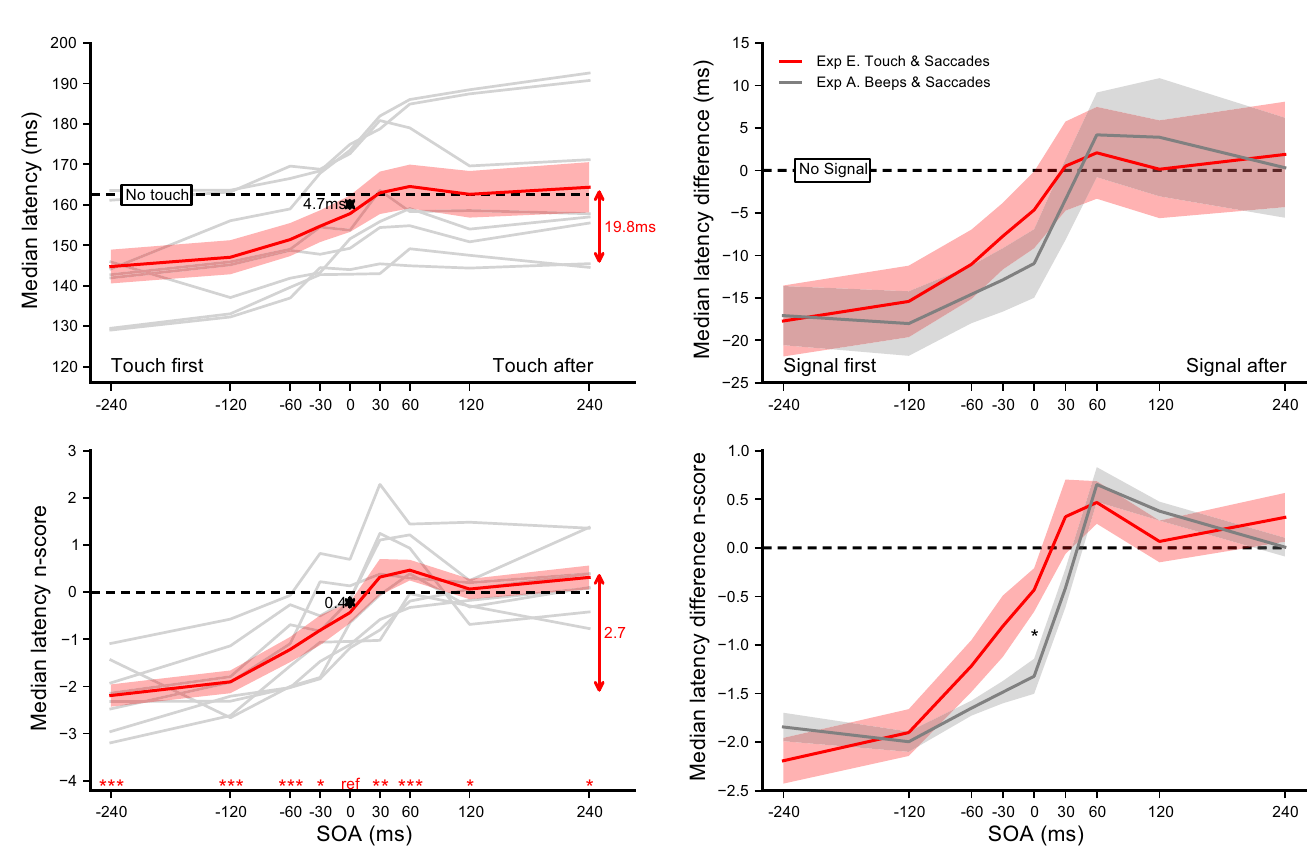
Fig 6. Experiment E. Effect of tactile stimulation on saccade onset (left panel). Median latencies averaged across participants for each SOA condition (top) and the corresponding n scores (bottom). Dashed lines show the No touch condition level and grey lines show individual results. Error bars indicate inter-individual SEM. Statistics included a single sample t-test performed on the n scores of the SOA = 0 ms reference condition to highlight the difference with the No touch condition (black arrow), and paired t-tests comparing this reference with each of the other SOA condition (red stars for each SOA above the X-axis). Auditory beeps vs. tactile vibration (right panel). Comparison between experiment E (red plot) and A (grey plot): median latency differences (top) and n score differences (bottom) aligned on the No signal condition (dashed lines). Statistics were unrelated t-tests performed on the n score differences between experiments for each of the 9 SOA conditions. Three stars indicate highly significant differences after Bonferroni correction (p < 0.00555) while single stars and two stars significant differences without correction (p < 0.05 and p < 0.01 respectively). Red arrows indicate the overall range of